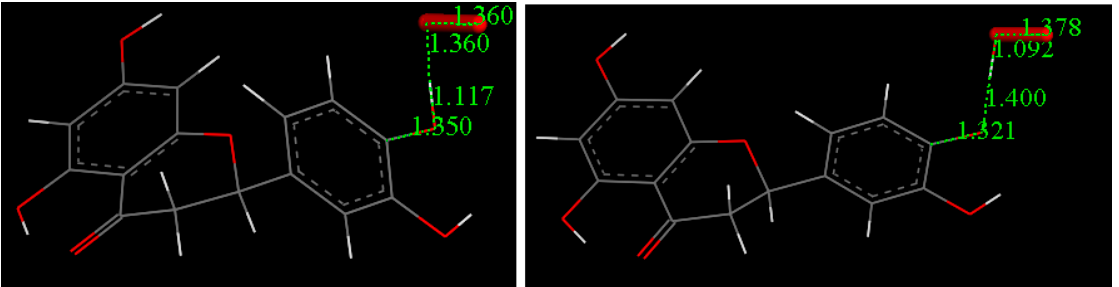
Figure 17 Minimized reagent, left, and product, right, for eriodictyol scavenging superoxide. Figure 17. Minimized reagent, left, and product, right, for eriodictyol scavenging